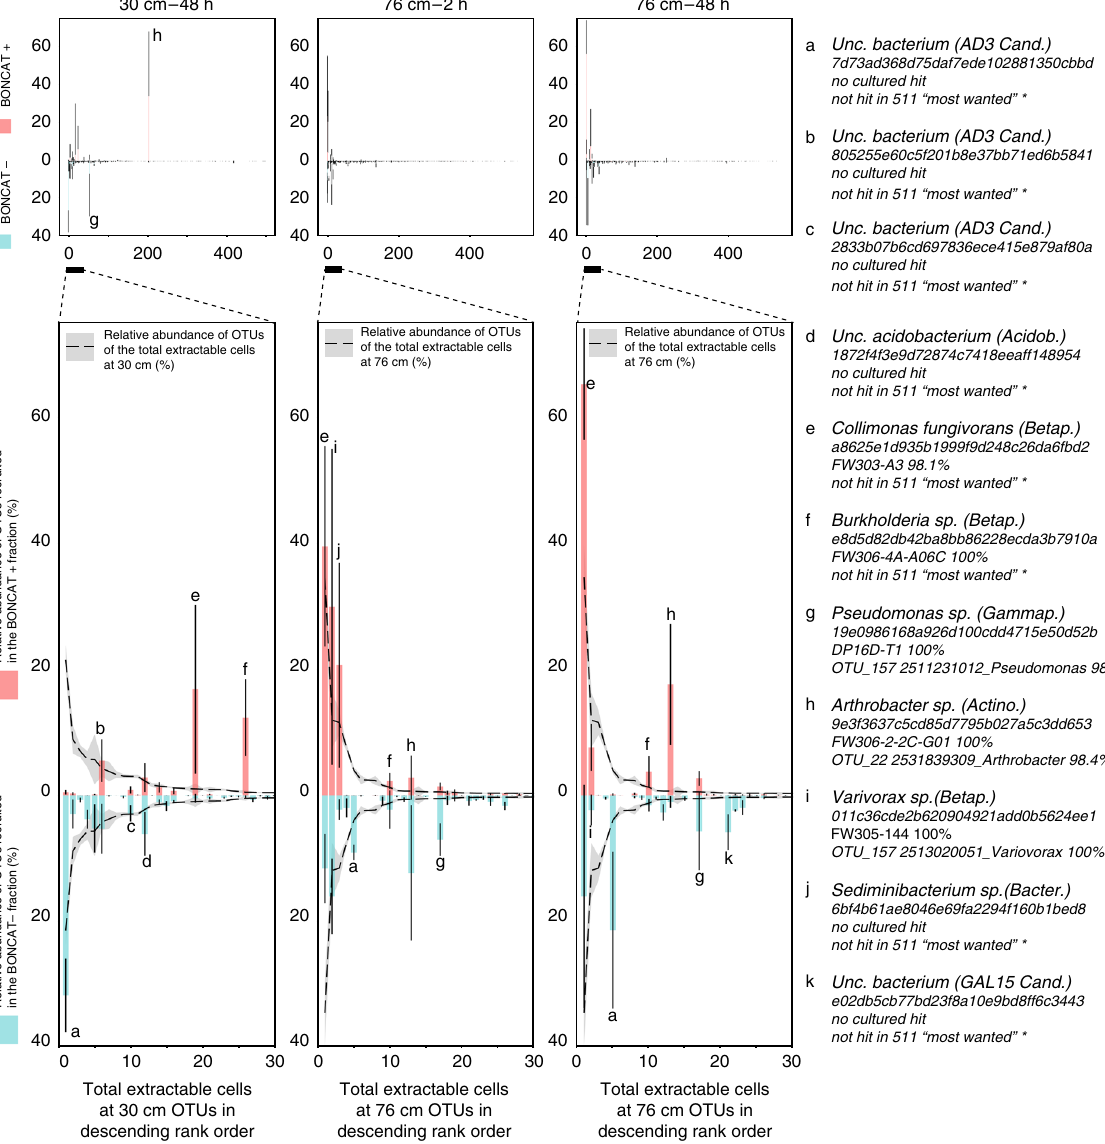
Fig. 3 Comparing the composition of the BONCAT + and BONCAT − populations. a Relative abundance (in percent, ±SD, n = 3) of OTUs present in the BONCAT + (red) and BONCAT − (blue) for the 30 cm – 48 h incubation (left panel), 76 cm – 2 h incubation (middle panel) and 76 cm – 48 h incubation (right panel). The OTUs have been ranked in descending order from left to right according to their relative abundance on the fi lter samples (all cells detached and captured on a fi lter). b Close-up on the 30 most abundant OTUs overlaid with their abundance on the fi lter samples (dashed line, ±SD shows as gray shading n = 3). The most abundant OTUs are indexed from a to k. Their taxonomy, ID, hit in the ENIGMA culture collection and matches to the 511 most abundant soil microbiome 29 is provided on the right legend panel. Error bars represent standard deviation ( n =